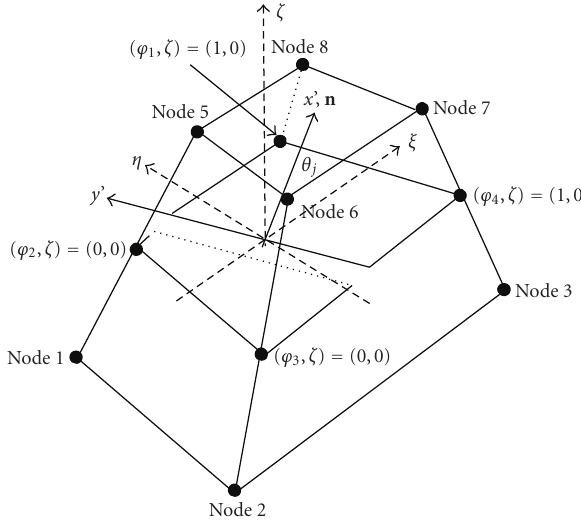
Figure 2: Determination of the characteristic length for hexahe- dron elements.